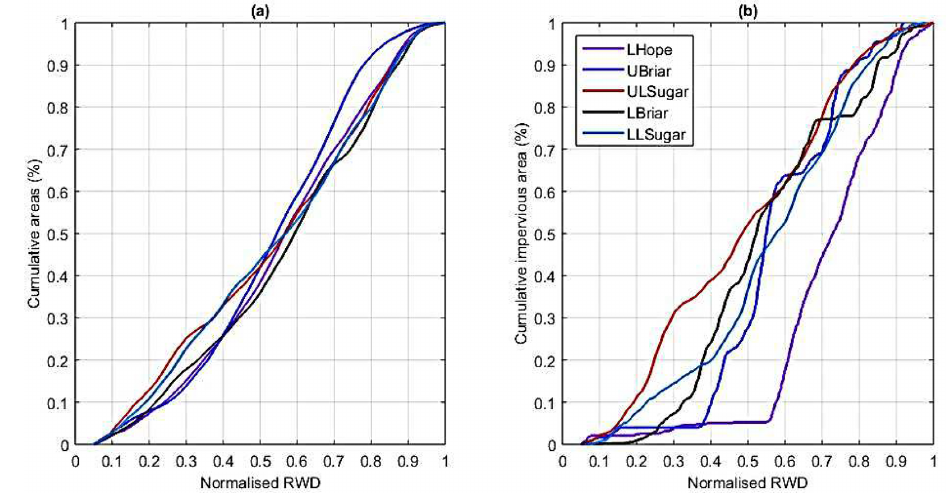
Figure 8. Cumulative distribution of catchment area (a) and of impervious areas (b) as a function of distance along the flow-path network, for the five basins in Little Sugar Creek